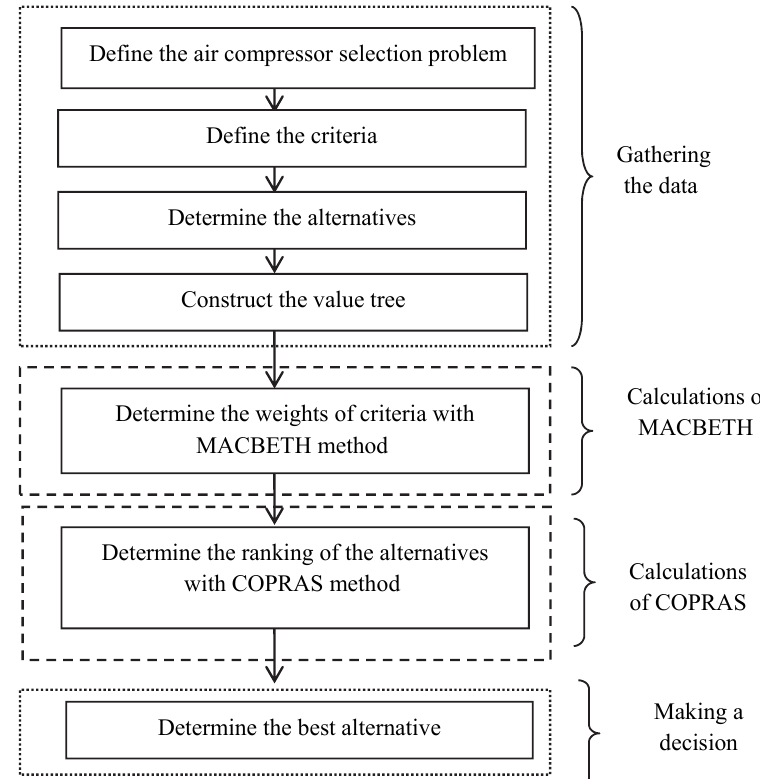
Fig. 1. Flow chart of the integrated